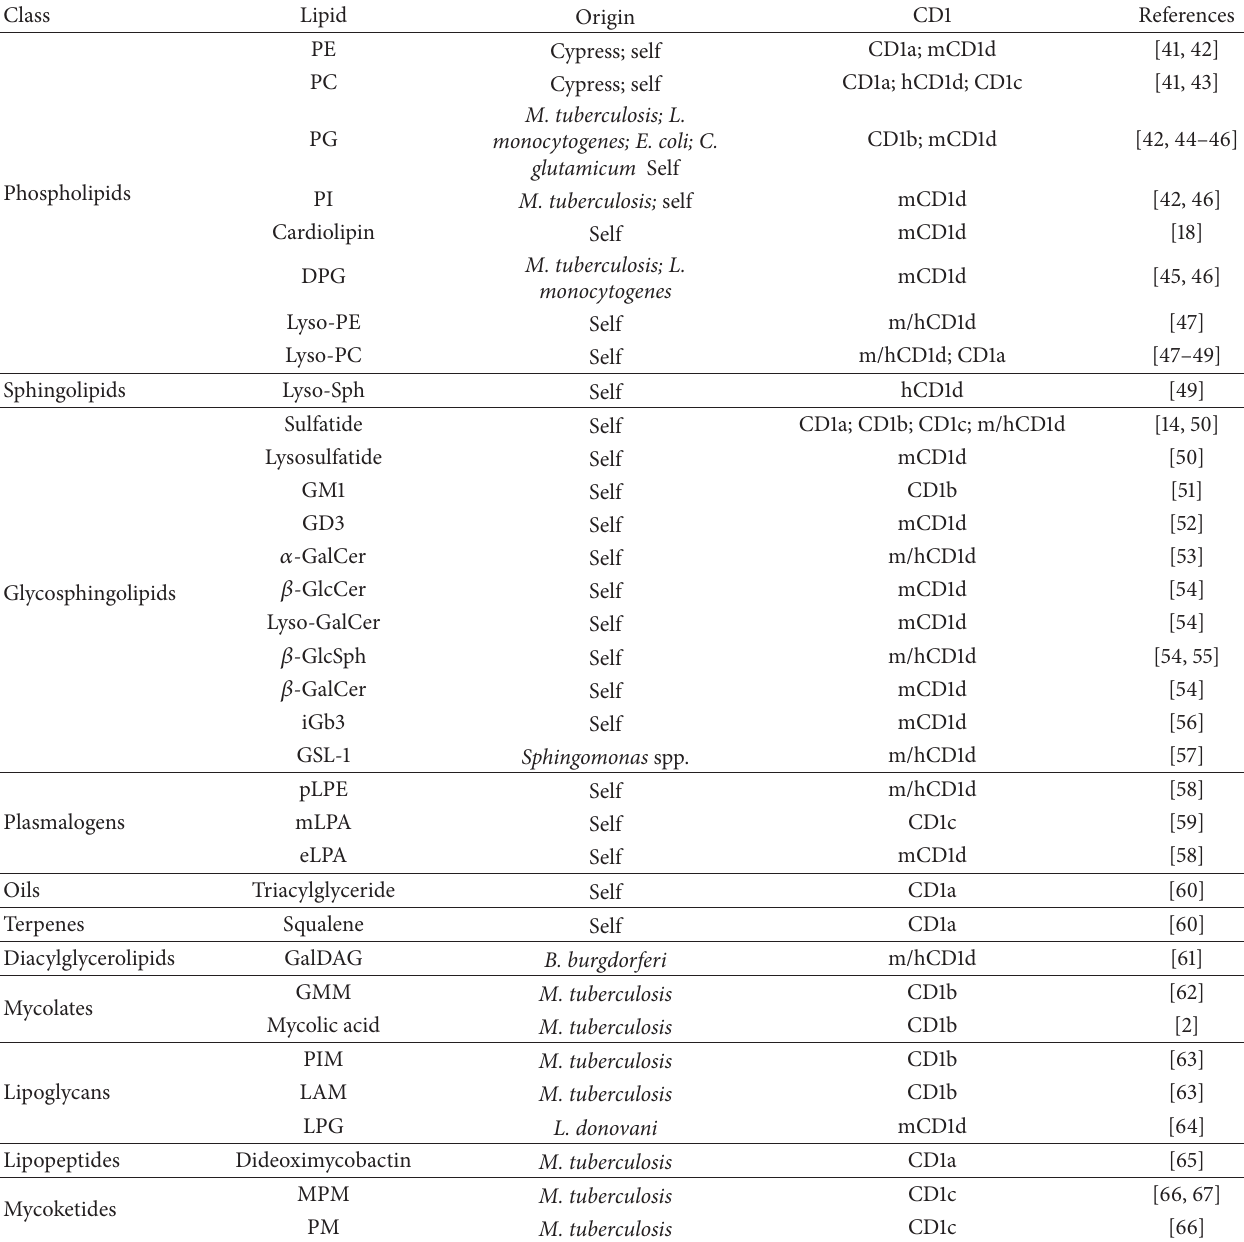
Table 1: Naturally occurring antigens for CD1-restricted T